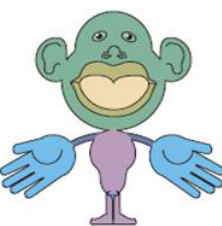
Figure 1. The somatosensory homunculus is often used to teach medical and health-science students about the somatosensory cortex of the human brain, and represents the mapping of the human brain. The size of the homunculus’ head and hands are relatively proportional to the large amount of the somatosensory cortex of the brain devoted to these regions. Taken from [70], page 205.